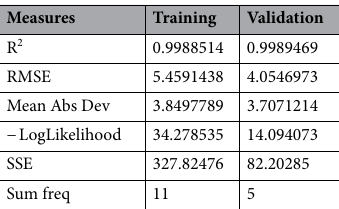
Table 1. Analysis of training/validation